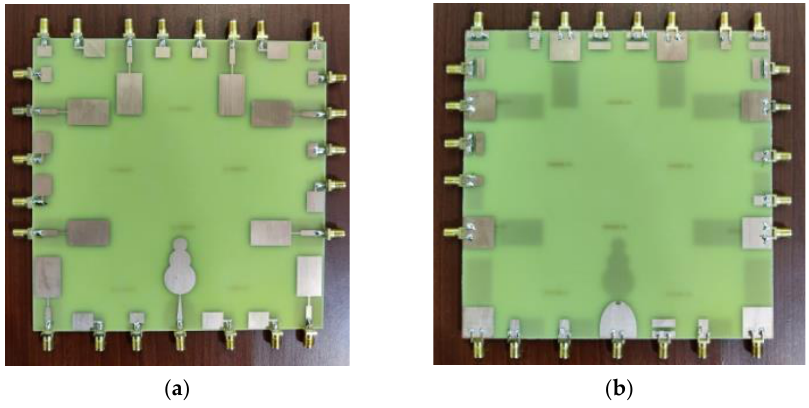
Figure 32. Fabricated prototype of the 25-port CR MIMO antenna. ( a ) Top view. ( b ) Bottom view . It can be observed from Table 3 that no CR 8-element MIMO antennas appear in the existing literature. Additionally, the proposed 8-element MIMO antenna achieves polarization diversity and covers all communication bands from 2.17 to 12 GHz. Moreover, it does not have any switching elements such as PIN diodes, MEMS, varactor diodes, or other factors. Table 3. Comparison of the 25-port CR MIMO antenna with other antennas in the literature . Ref.